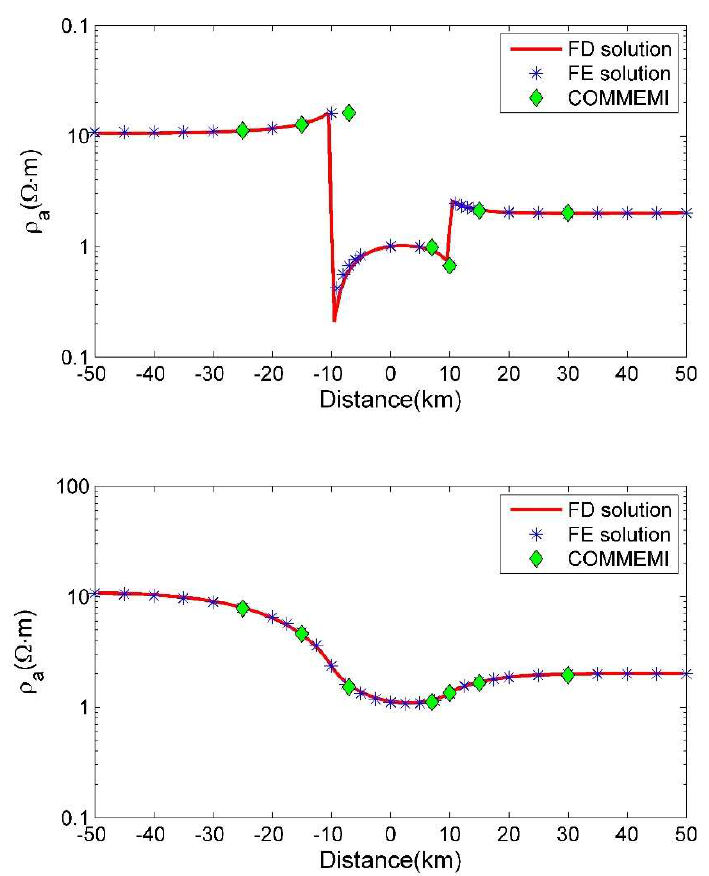
Figure 6. Comparison of FD solution and FE solution for the COMMEMI 2D-0 model. The upper figure displays the apparent resistivity of TM-mode, the lower figure represents the TE-mode.